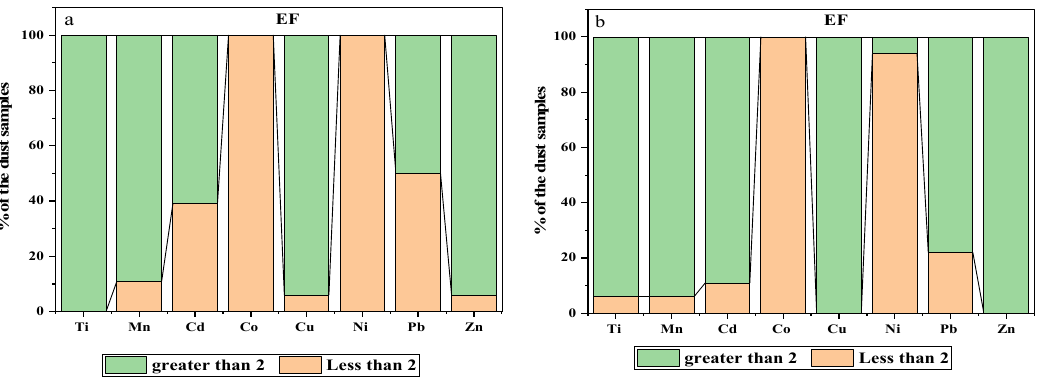
Figure 4. The average percentage of dust samples having enrichment factor (EF) more or less than 2 (( a ) outdoor dust samples; ( b ) indoor dust samples).